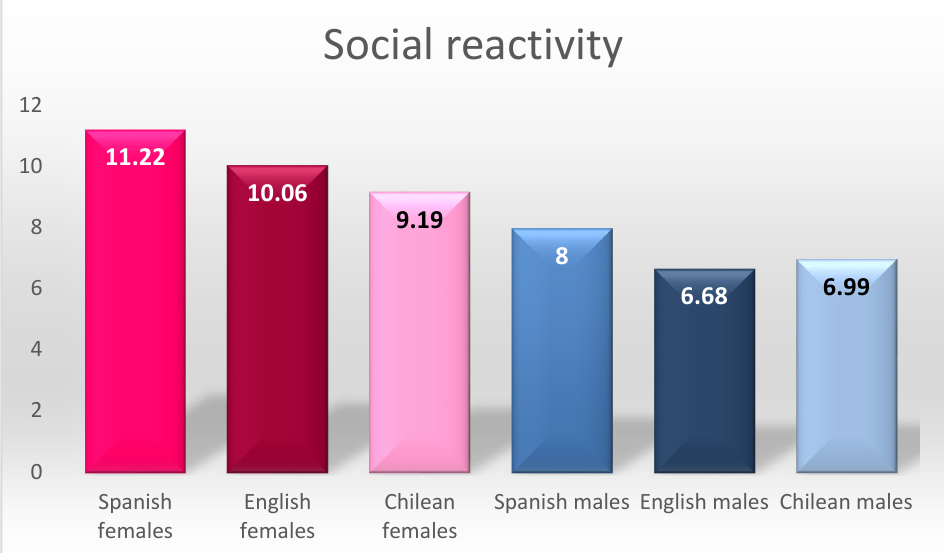
Figure 2. Summary of differences in social